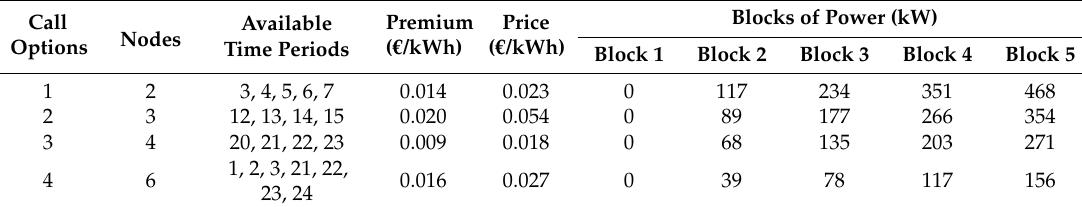
Table 4. Characteristics of the call